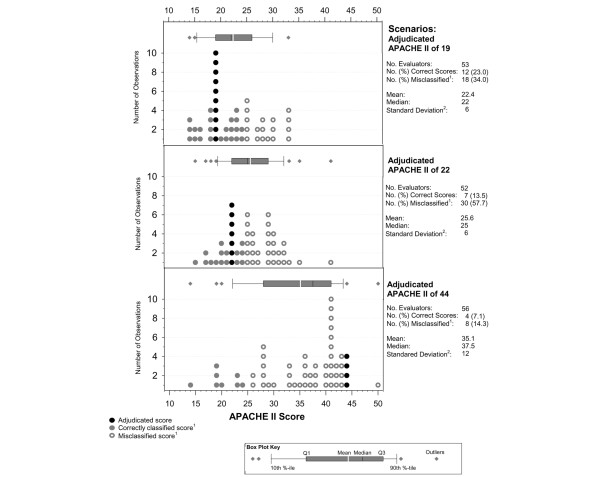
Results of the scoring exercise. The results of the scoring exercise completed by researchers involved in a large randomized placebo-controlled critical care trial illustrating individual scores, standard deviations and inter-quartile ranges of case scenarios with adjudicated total APACHE II scores of 44, 22 and 19. 1Correct classification is determined by the adjudicated score being either APACHE II ≥25 or APACHE II <25. 2Standard deviation is calculated using the adjudicated APACHE II score in place of the mean APACHE II score.